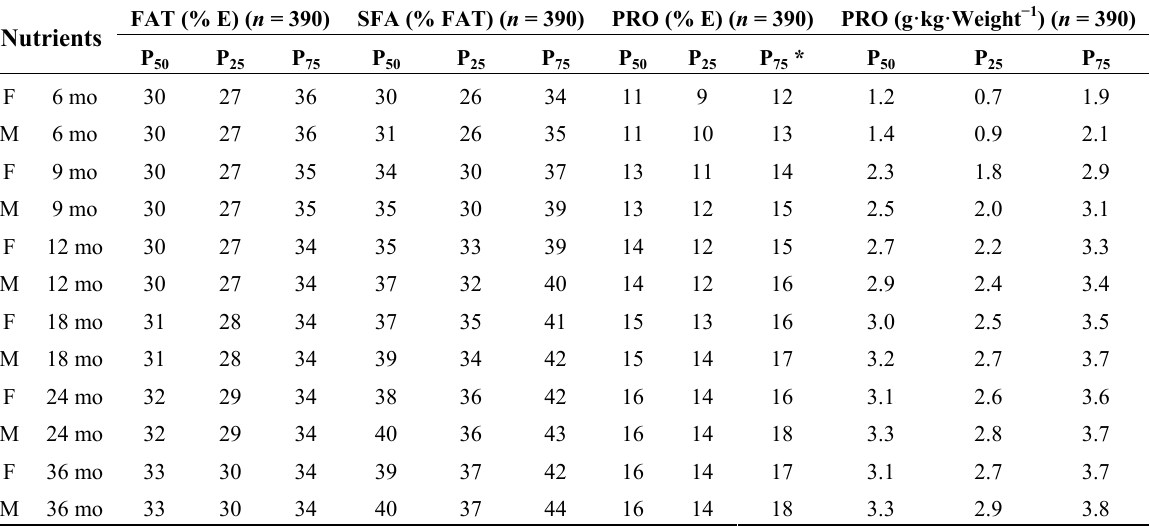
Table 6. Percentiles of fat and protein intake in the pooled sample of NI636 children.